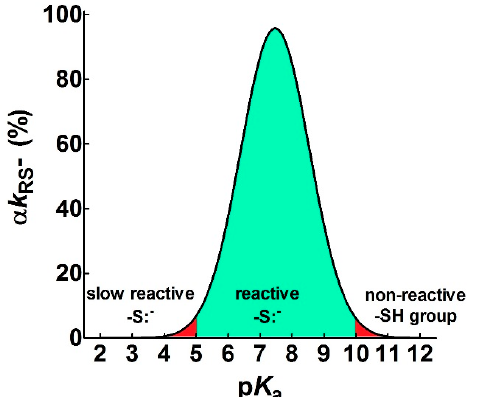
Figure 7. Theoretical curve defining the range of useful p K a ( α k RS − ≥ 5%) for a reacting thiolate group. The figure shows the p K a range that allows a sufficient rate of reaction of a protein cysteine with different reagents (green area) at pH = 7.4. Values with α k RS − < 5% are reported in red. The continuous line represents an average of the experimental curves reported in Figure 1.